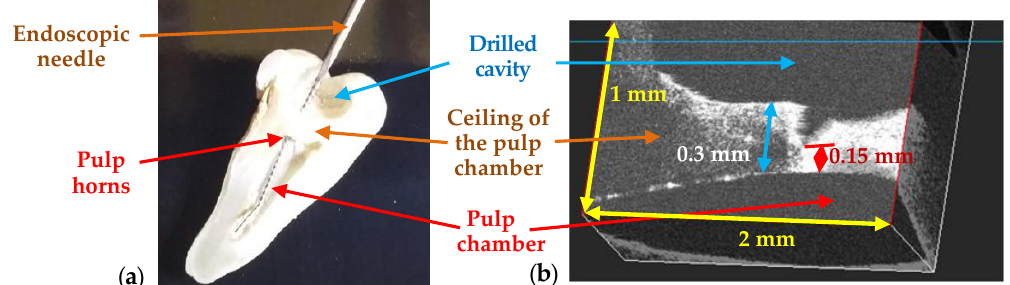
Figure 20. ( a ) Tooth morphology, sectioned after the procedure, showing the Remaining Dental Thickness (RDT) between the drilled cavity and the pulp chamber. An endodontic needle is inserted through the drilled cavity towards the pulp chamber, via the pulp horns, therefore the drilling process has a ff ected the pulp chamber. ( b ) Real-time OCT evaluation of the RDT, showing its decrease to a critical value, for which a fracture occurs-from the detailed study in